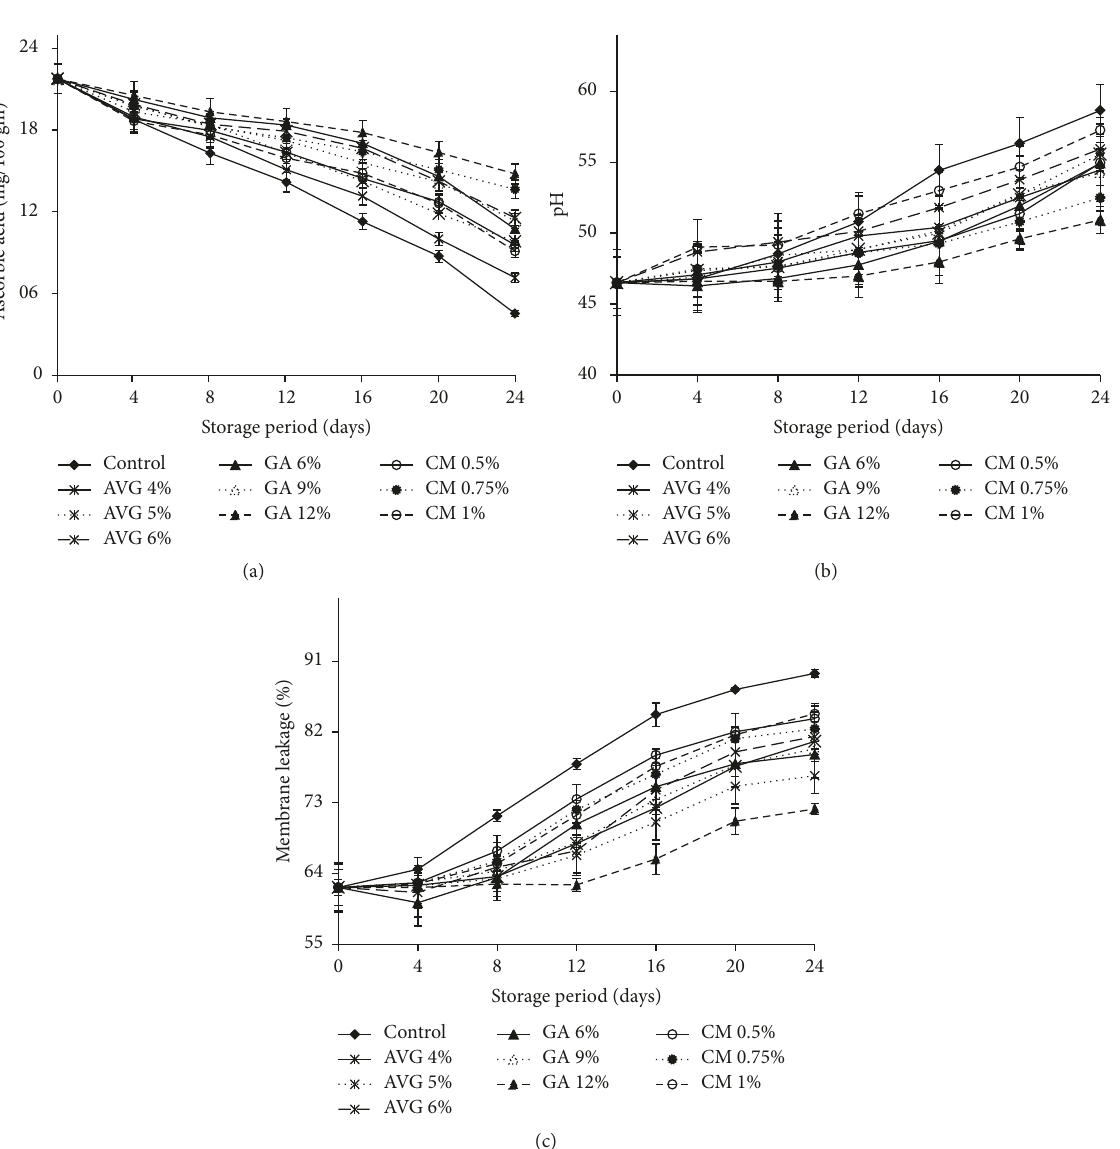
Figure 3: Effect of different coating treatments on the ascorbic acid, pH, and membrane leakage of bell pepper during cold storage at 8 ± 1 ∘ C for 24